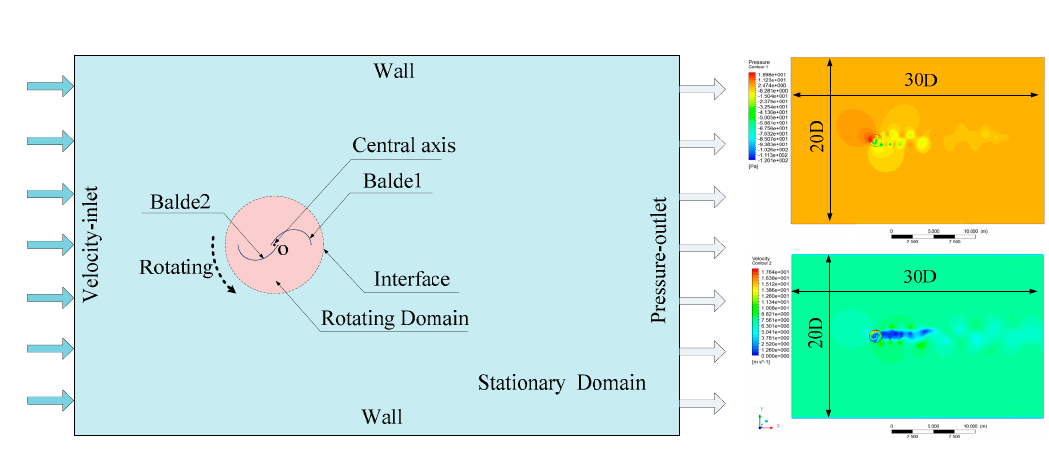
Figure 4. Simulation domains.